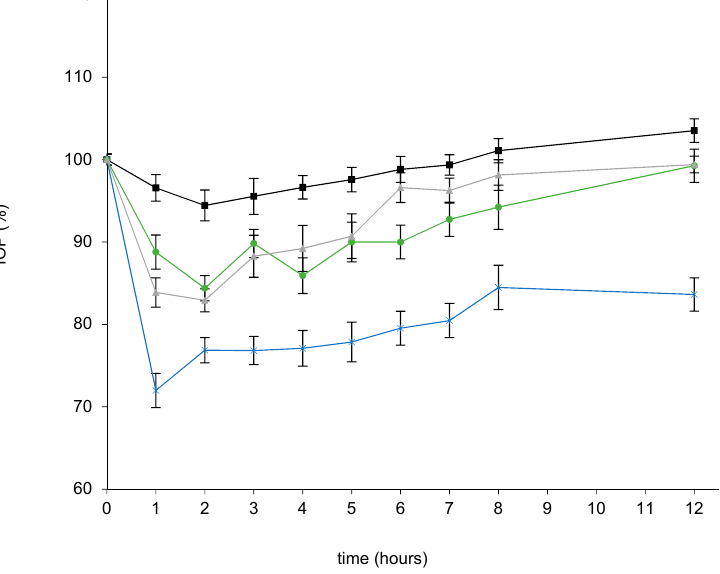
Figure5. IOP%profileofthefollowingformulations: ( (cid:78) )Marketedformulation(TM0.5%), ( • )TMGNP3 (0.1%), ( × ) TMGNP3 (0.1%) + HPMC 0.3% and ( (cid:4) ) blank gelatin nanoparticles used as Figure 5. IOP % profile of the following formulations: ( ▲ ) Marketed formulation (TM 0.5%), ( ● ) TMGNP3 (0.1%), ( × ) TMGNP3 (0.1%) + HPMC 0.3% and ( ■ ) blank gelatin nanoparticles used as